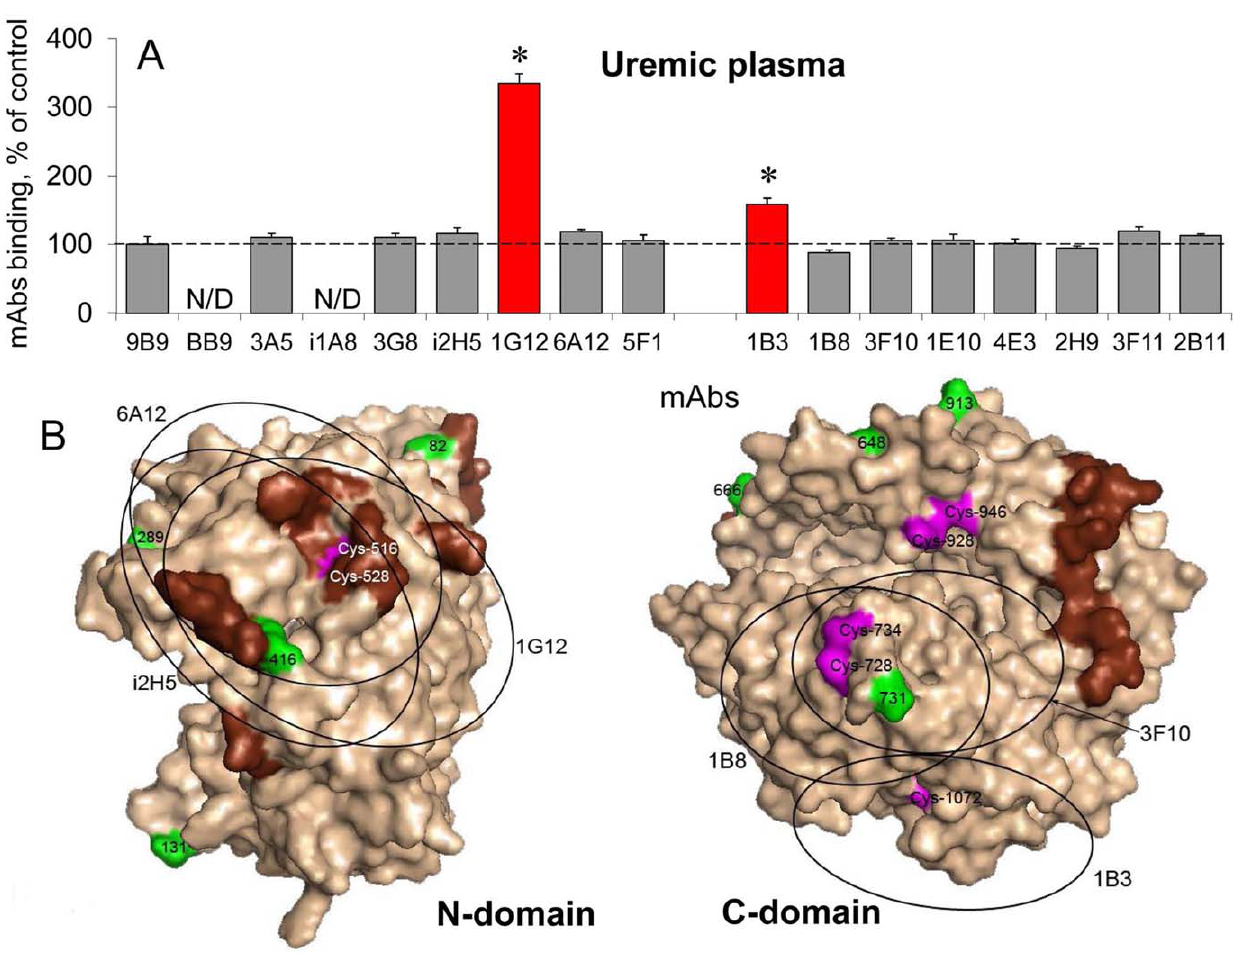
Figure 4. Conformational fingerprinting of uremic plasma with highly elevated 1G12/9B9 ratio and normal Z/H ratio. A . ACE activity precipitated by different mAbs from plasma of uremic patients with highly elevated 1G12/9B9 ratio and normal Z/H ratio (mean data for uremic samples # 7 and # 16 from Fig. 3) as a percentage from that for plasma from uremic persons with normal 1G12/9B9 and ZPHL/HHL ratios (mean data of two uremic samples # 5 and # 18 from Fig. 3) taken as control. Data presented are mean 6 SD of duplicates from 2 experiments. The red-colored columns show those antibodies which binding to blood ACE in uremic patients with high 1G12/9B9 ratio differ more than 20% from that for patients with normal 1G12/9B9 ratio. * – parameter from the test sample was statistically different (p , 0.05) from the healthy control. B . Localization of disulfide bridges and free cysteine residues in the epitopes for mAbs 1G12 together with overlapping epitopes for mAbs 6A12 and i2H5 on the N domain of ACE (left) and mAb 1B3 together with adjacent epitopes for mAbs 1B8 and 3F10 (on the C domain of ACE ). The regions of the epitopes for different mAbs were marked by circles with diameter of approximately 30A˚, which corresponds to the square of 600–900 A˚ 2 . Cysteine residues are marked magenta; potential glycosylation sites are marked green; amino acid residues participating in hinge-bending movement of domains are marked brown.